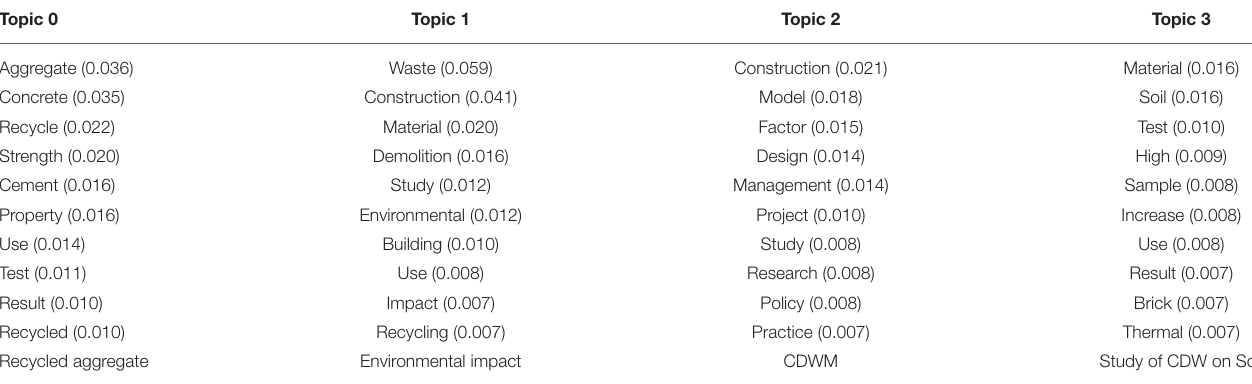
TABLE 1 | Topic-word probability